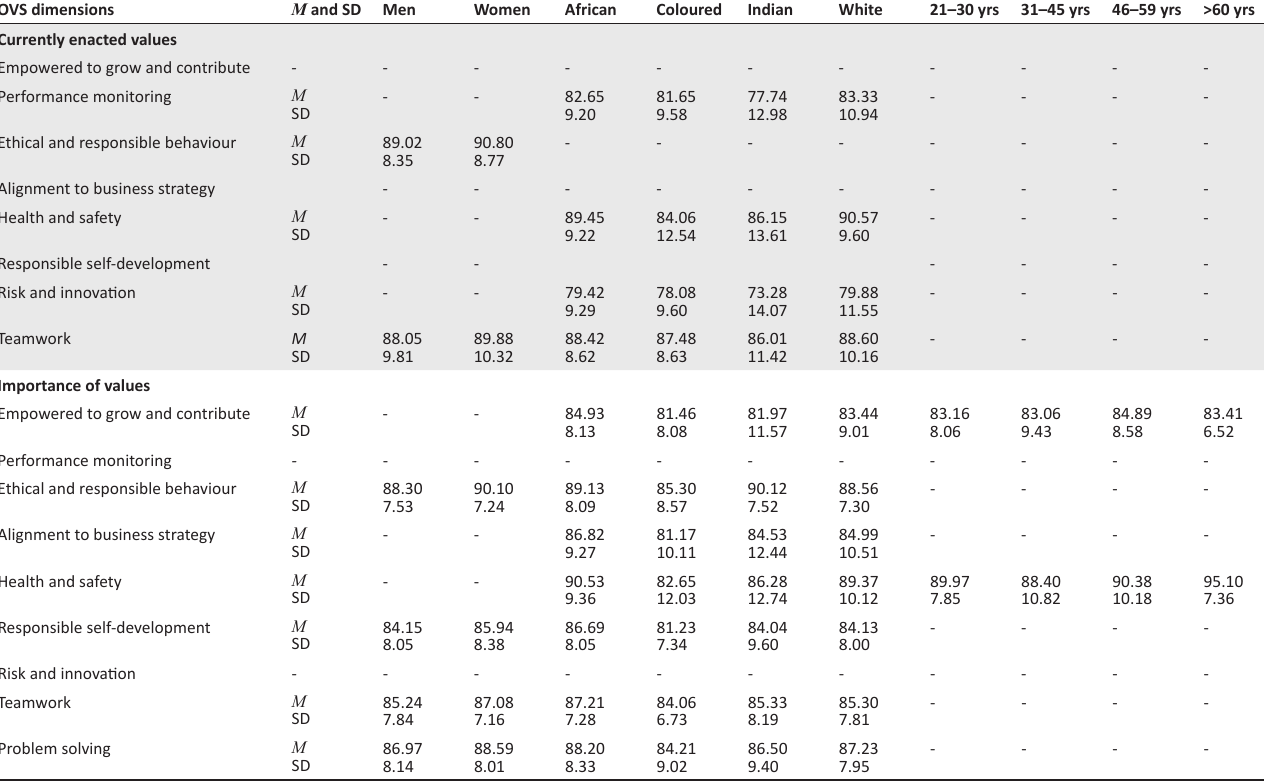
TABLE 6: Organisational Values Scale biographical groups – means and standard deviations of significant mean differences ( n = 988). OVS dimensions